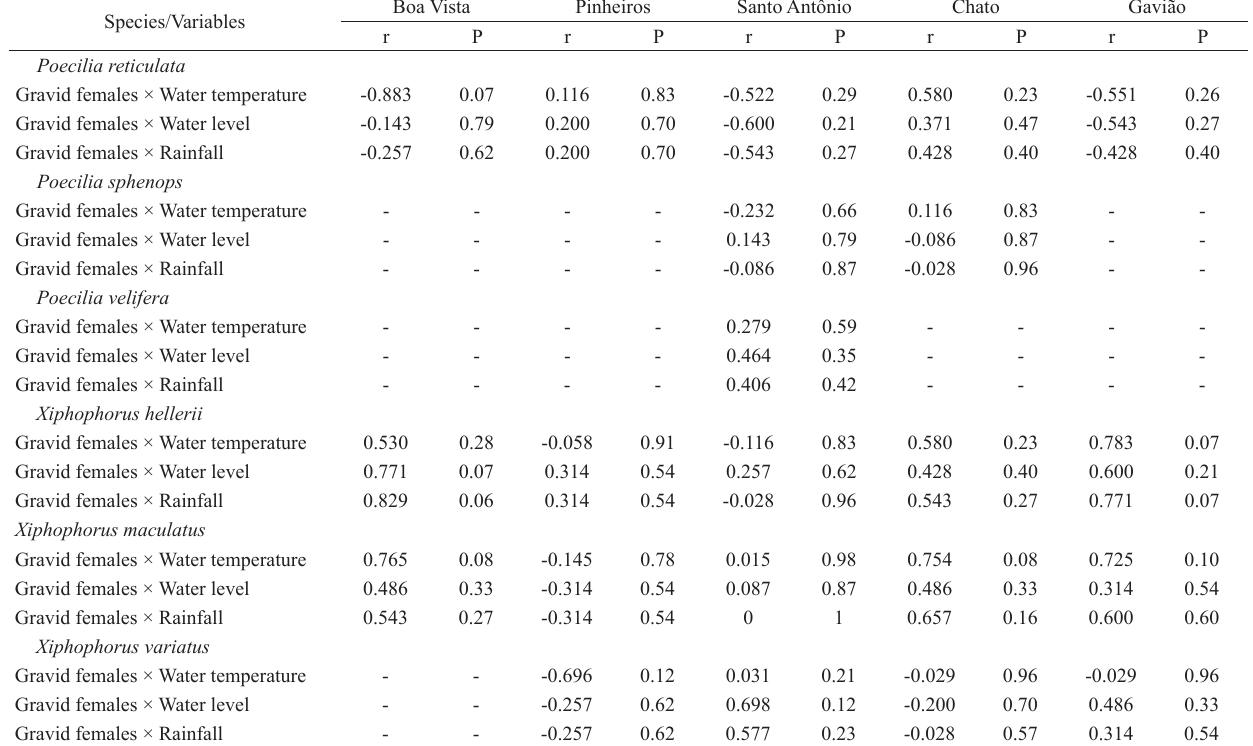
Tab. 4. Spearman’s rank correlation between ornamental non-native reproductive female poeciliids and abiotic variables in the creeks in 2003, 2004, 2005 and